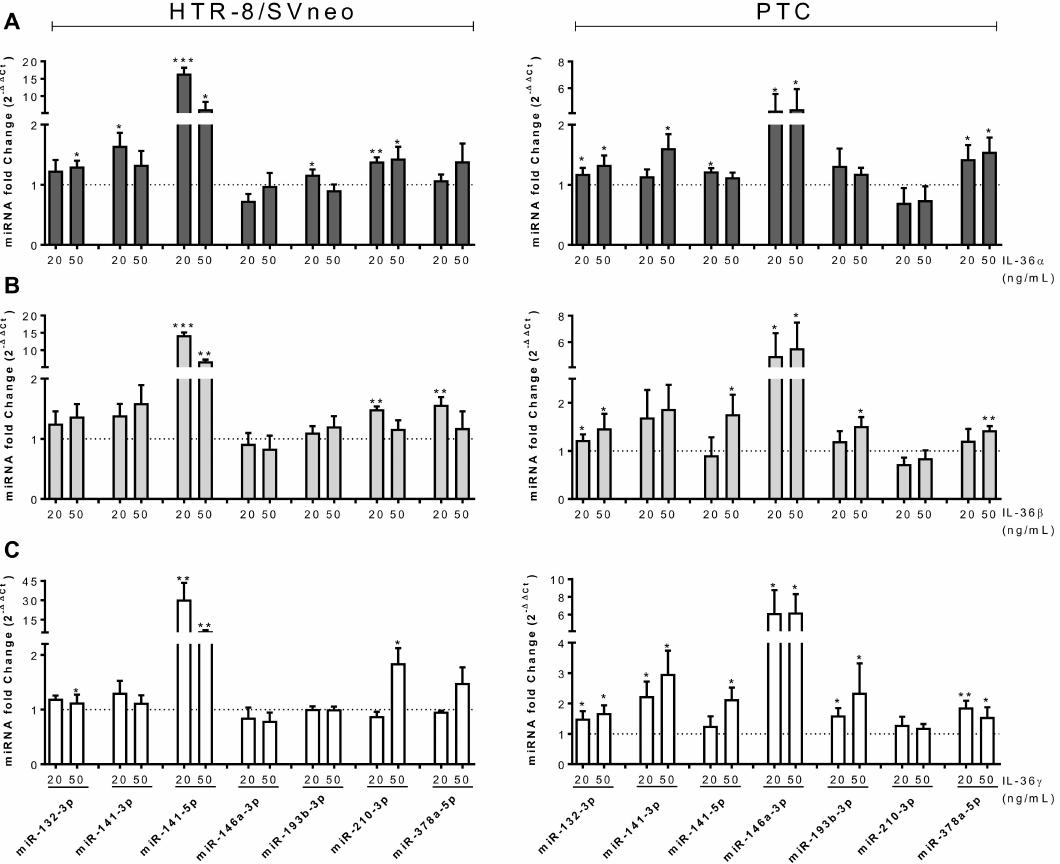
Figure 6. Recombinant IL-36 induces expression of miRNAs. HTR-8/SVneo cells (left) and PTC (right) were stimulated with 20 or 50 ng/mL of ( A ) IL-36 α , ( B ) IL-36- β , or ( C ) IL-36 γ ) for 24 h. miRNA levels were determined by quantitative real-time PCR and normalized using the 2 − ∆∆ Ct method to RNU48 and non-treated cells. Results from three independent experiments are shown as mean ± SEM. Unpaired two-tailed Student’s t-test with Welch ´ s correction. * p < 0.05, ** p < 0.01, *** p < 0.001 to non-treated cells (dotted